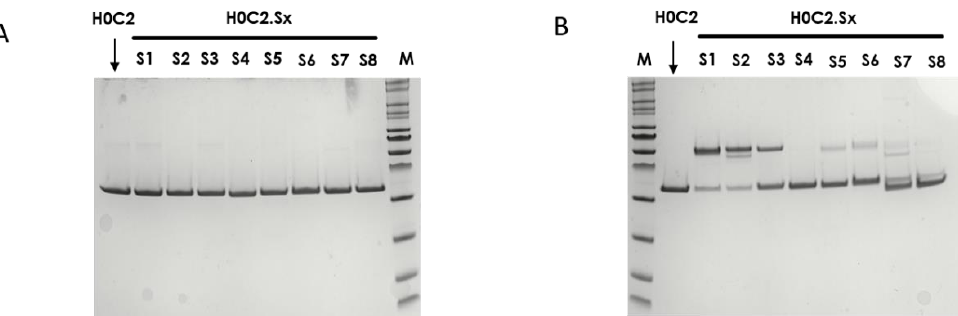
Figure 3. SDS-PAGE analysis to assess the integrity of fragments H0C2 (without intra-domain cys- teines (IDC)) and H0C2.Sx (with IDC): ( A ) Denaturating and reducting conditions; ( B ) Denaturating and non-reducting conditions.